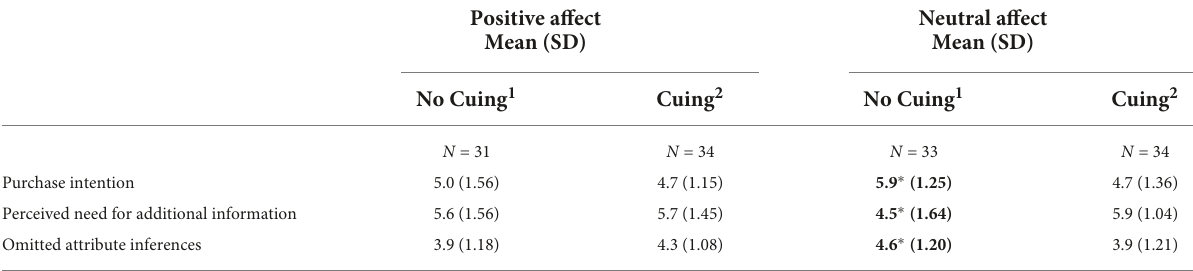
TABLE 3 Experiment 3: Purchase intention and omitted attribute inferences as a function of positive affect and omission